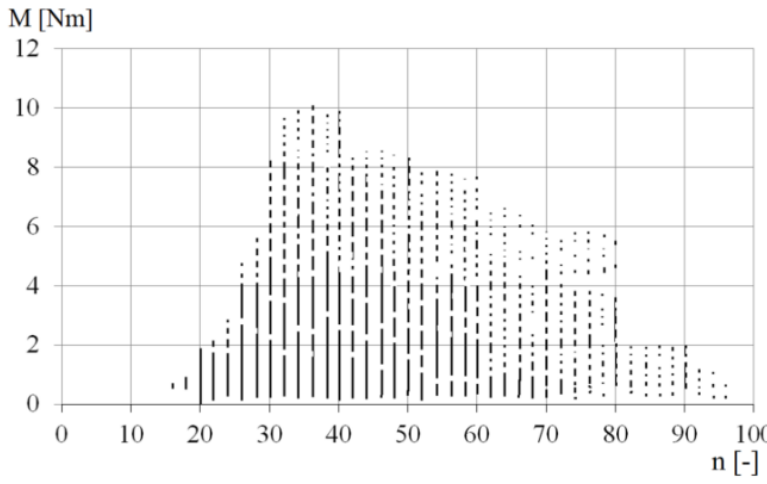
Figure 13. Dependence of the torque M on the number of blades n.